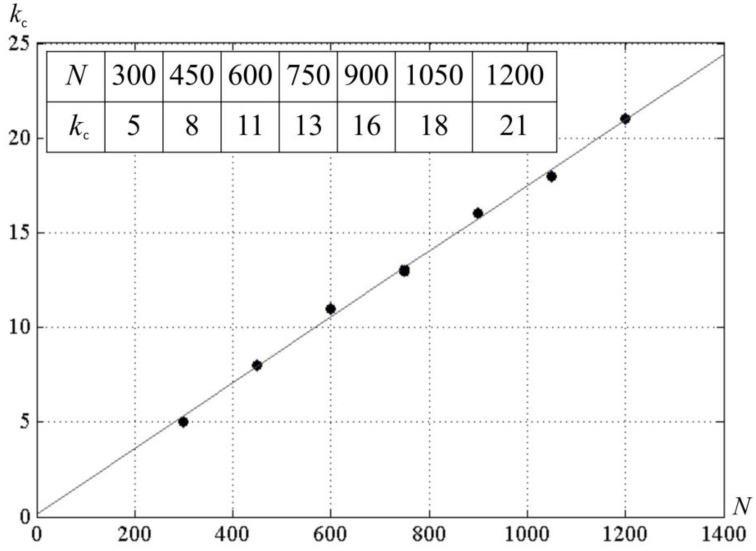
The dependence of kc on the number of neurons in the neural network N. D = 80, δ = 12, σ = 3; a line is a least square match of the computational experiment data.